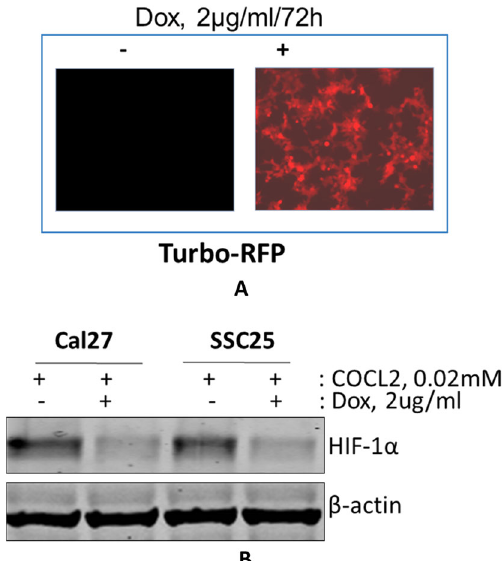
Figure 1 Lentivirus-mediated shRNA efficiently inhibited the expression of HIF ‑ 1 α in head and neck squamous carcinoma Cal27 and SCC2 cells. A . Fluorescence microscopic picture of the expressed reporter Turbo-RFP protein as a marker of successful transfection and doxycycline indelibility. Lentivirus doxycycline-inducible pTRIPZ- shRNAmir constructs directed against HIF ‑ 1 α used to transfect Cal27 and SCC25 HNSCC cells. The construct also contains a doxycycline- inducible TurboRFP as a reporter gene co-expressed with the shRNA sequence. B. Immunoblot with anti- HIF ‑ 1 α showed that doxycycline-induced HIF-shRNAmir reduced the HIF ‑ 1 α protein